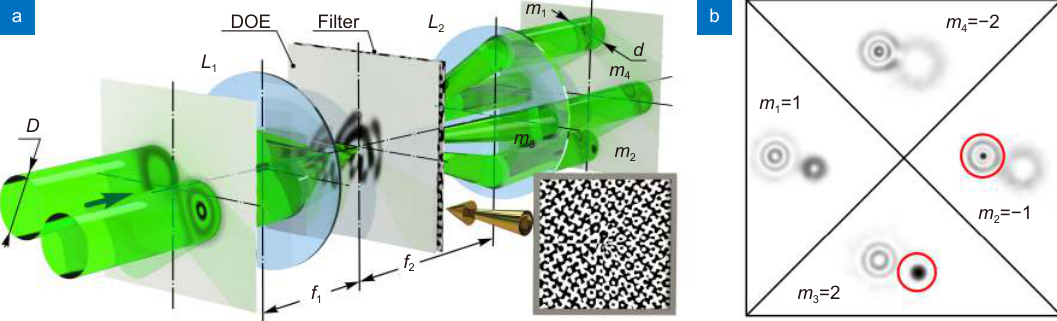
Fig. 19 | Instantaneous recognition of particular vortex positions of Laguerre–Gaussian beams. ( a ) The correlation network with a multi- channel DOE. ( b ) Results of detection (correlation peaks circled in red) in the focal plane. Figure reproduced from ref. 192 , under a Creative Com- mons Attribution.